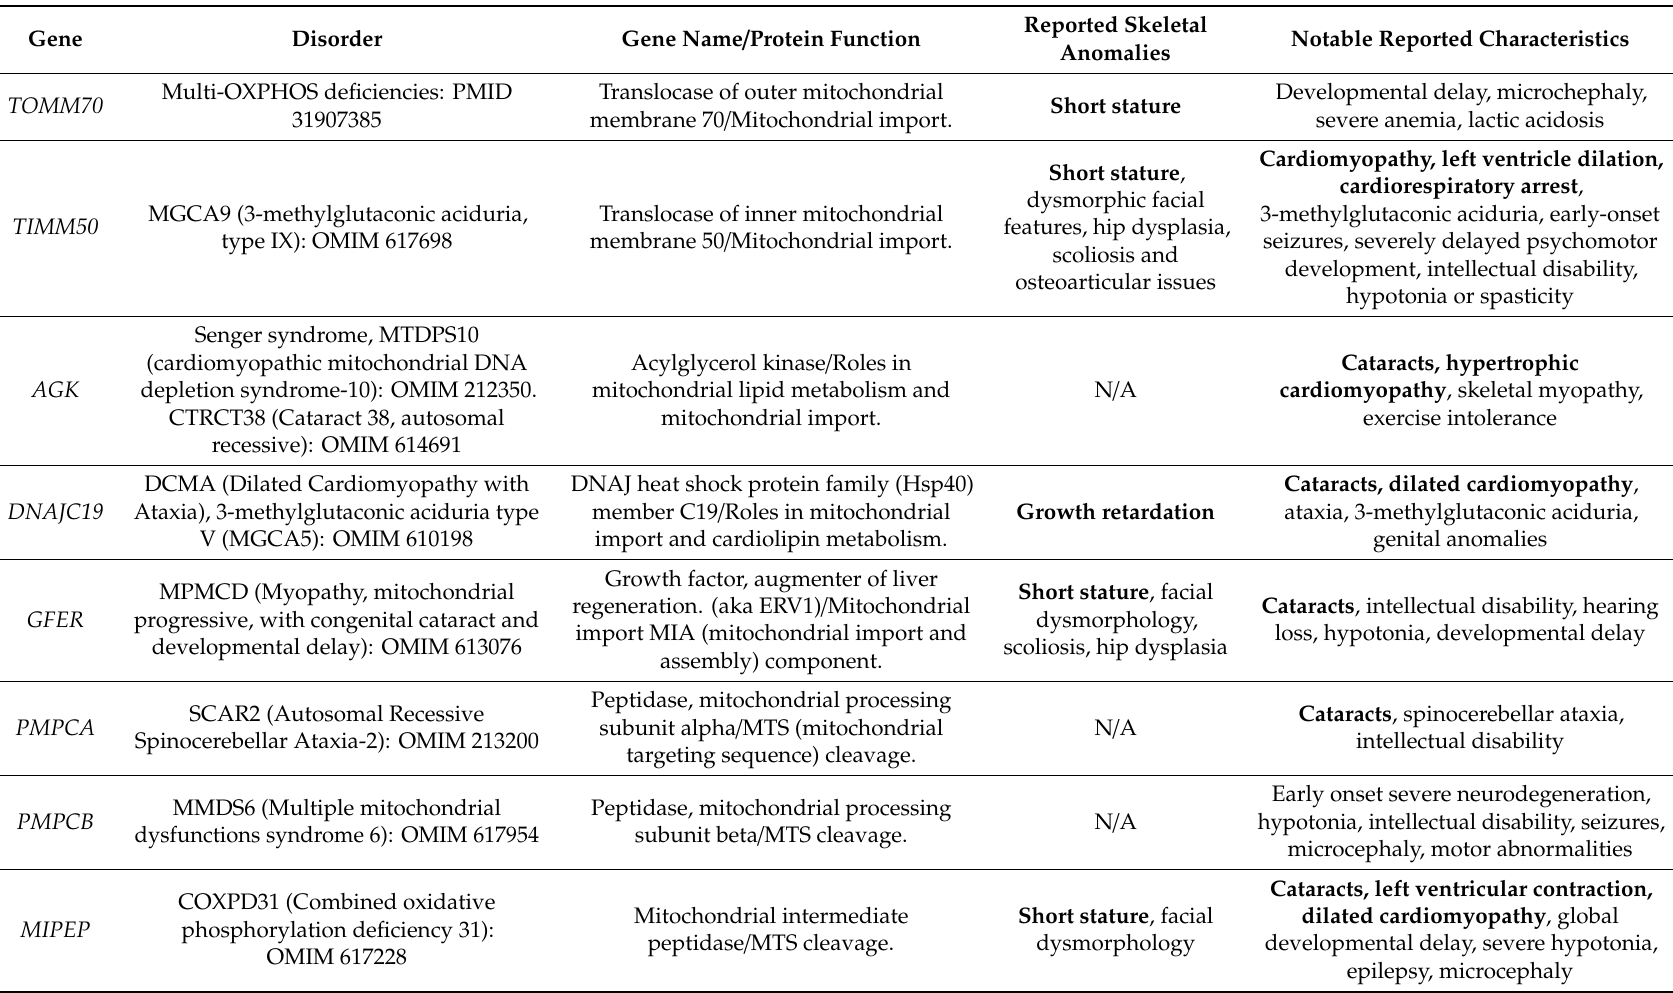
Table 3. Genes encoding mitochondrial import proteins implicated in mitochondrial disease, indicating formal OMIM (Online Mendelian Inheritance in Man) disease designations, gene names, protein functions, and phenotypic descriptions. Disease phenotypes indicted in bold are also common in mitochondrial skeletal